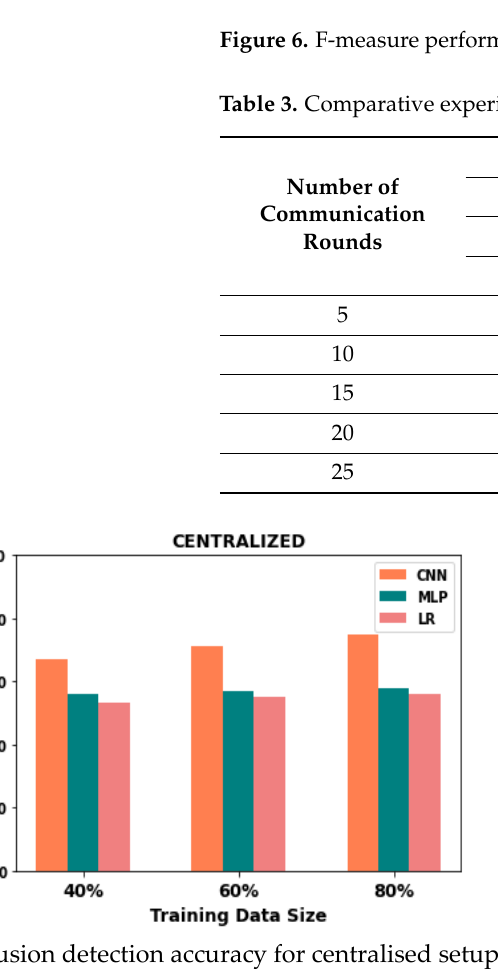
Figure 7. Intrusion detection accuracy performance. Table 4. Comparative experimental results of intrusion detection accuracy.